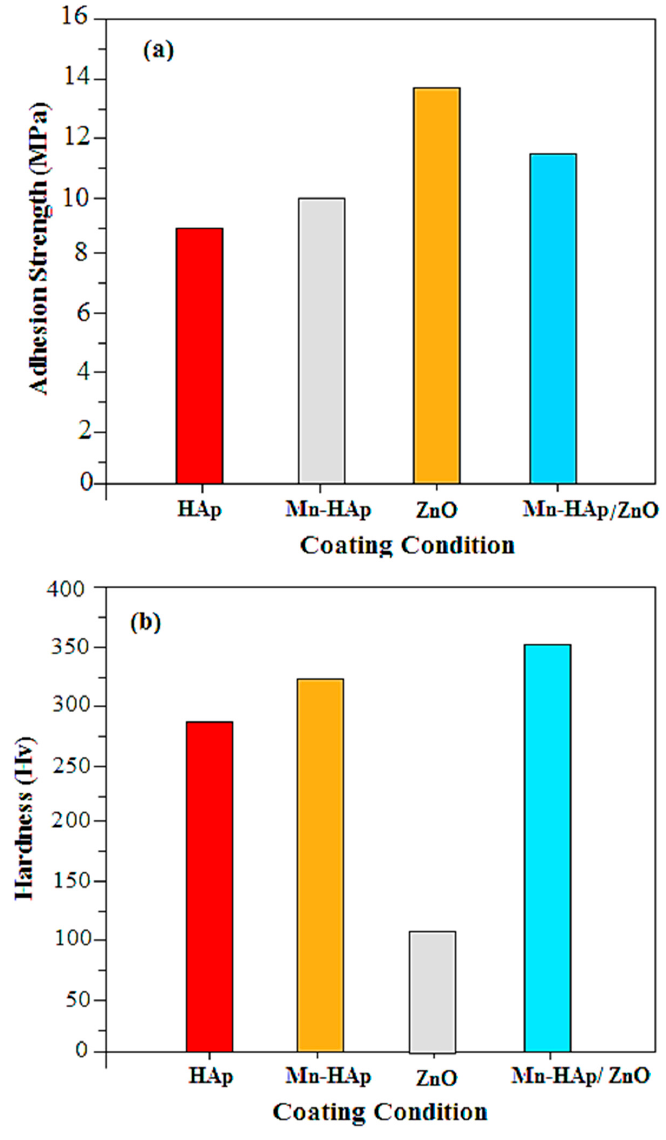
Figure 6. ( a ) Adhesion strength; ( b ) hardness strength of HAp, Mn-HAp, ZnO and Mn-HAp/ZnO bilayer coating on 316L